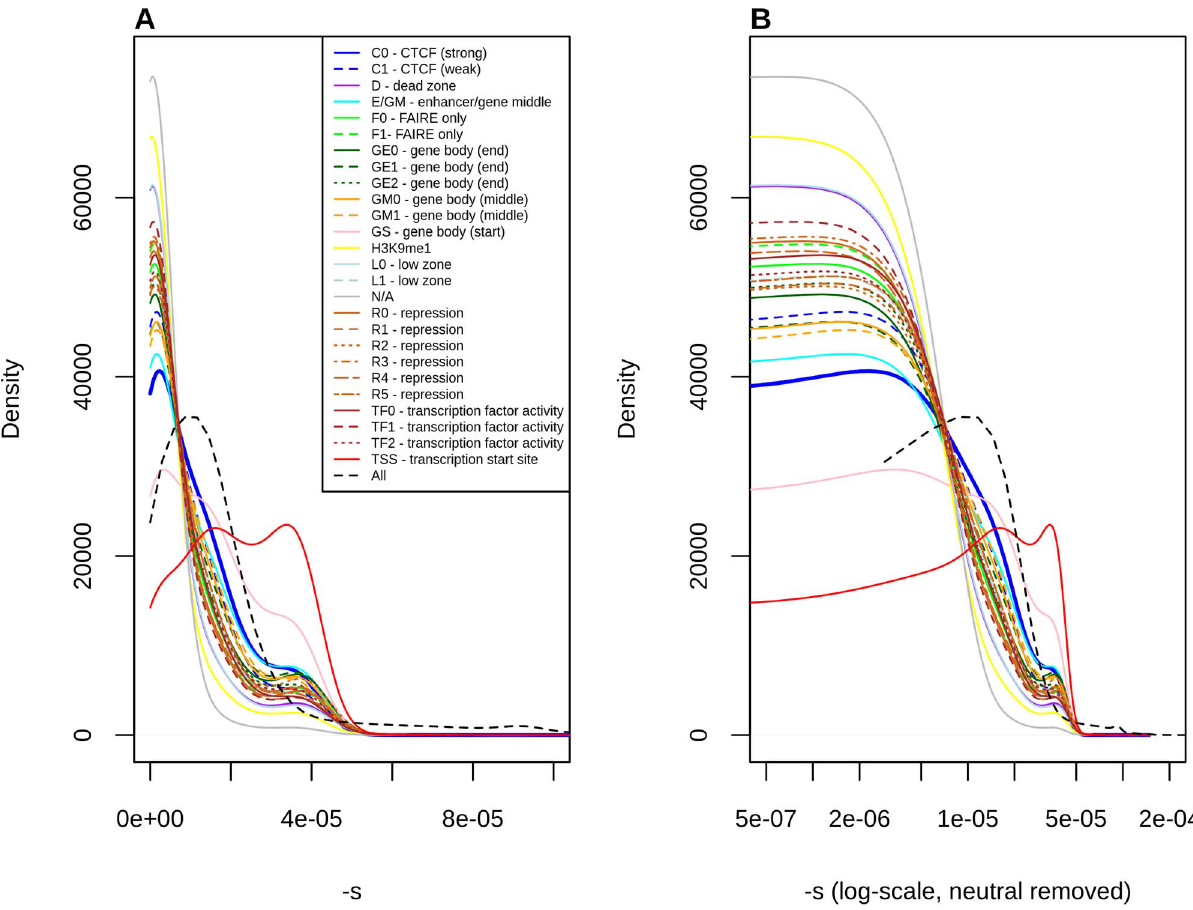
Figure 4. Distribution of fitness effects among YRI polymorphisms, partitioned by Segway regulatory segments, obtained using the C-to-s genome-wide mapping. Panel B shows a zoomed-in version of the distribution in panel A, after removing neutral polymorphisms and log- scaling the x-axis.